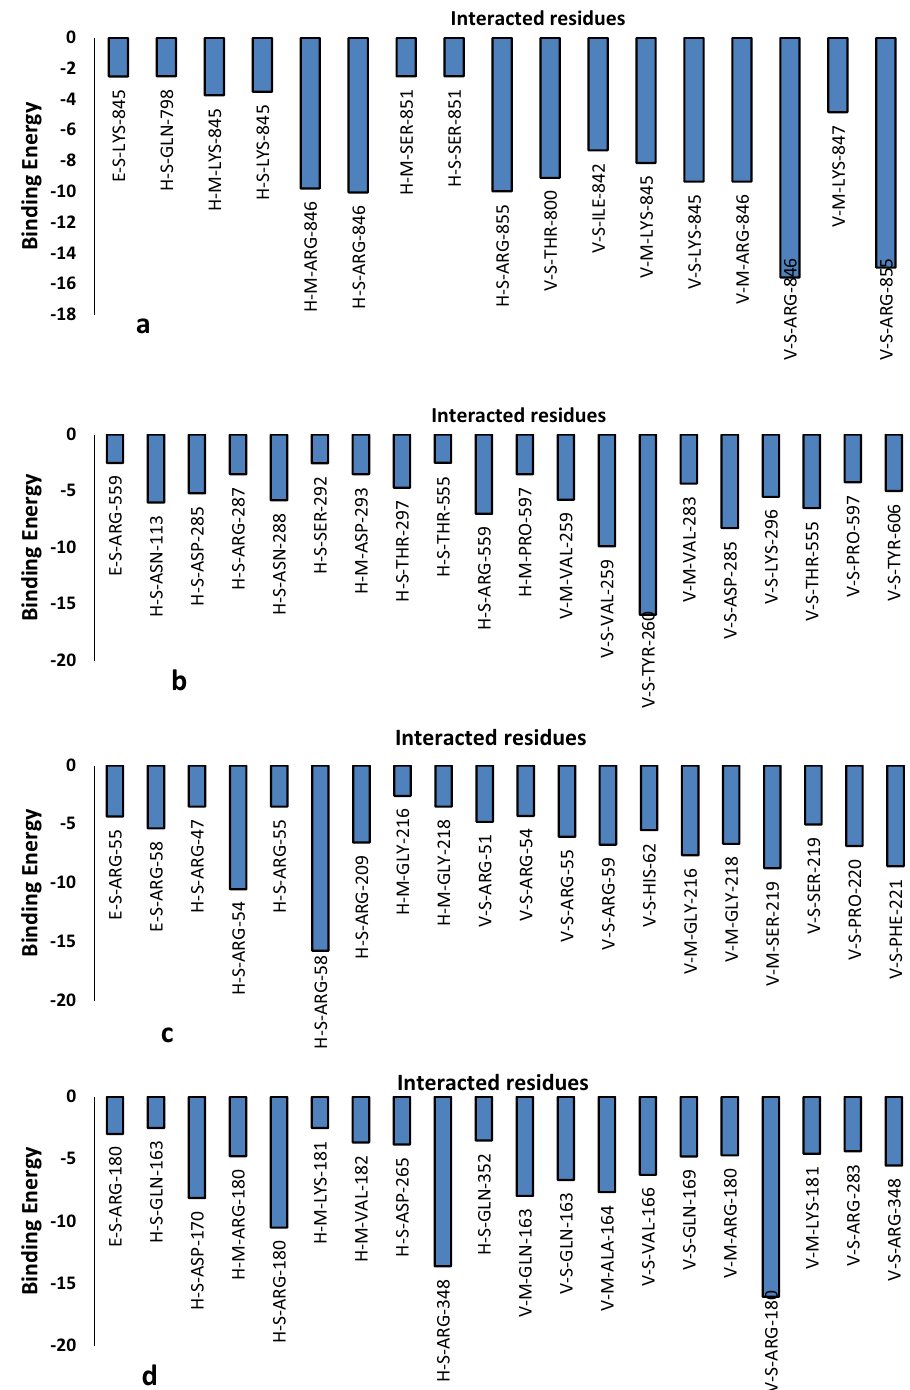
Figure 9. Plots of the amino acids significant interacted with pectin v/s energy contributed.